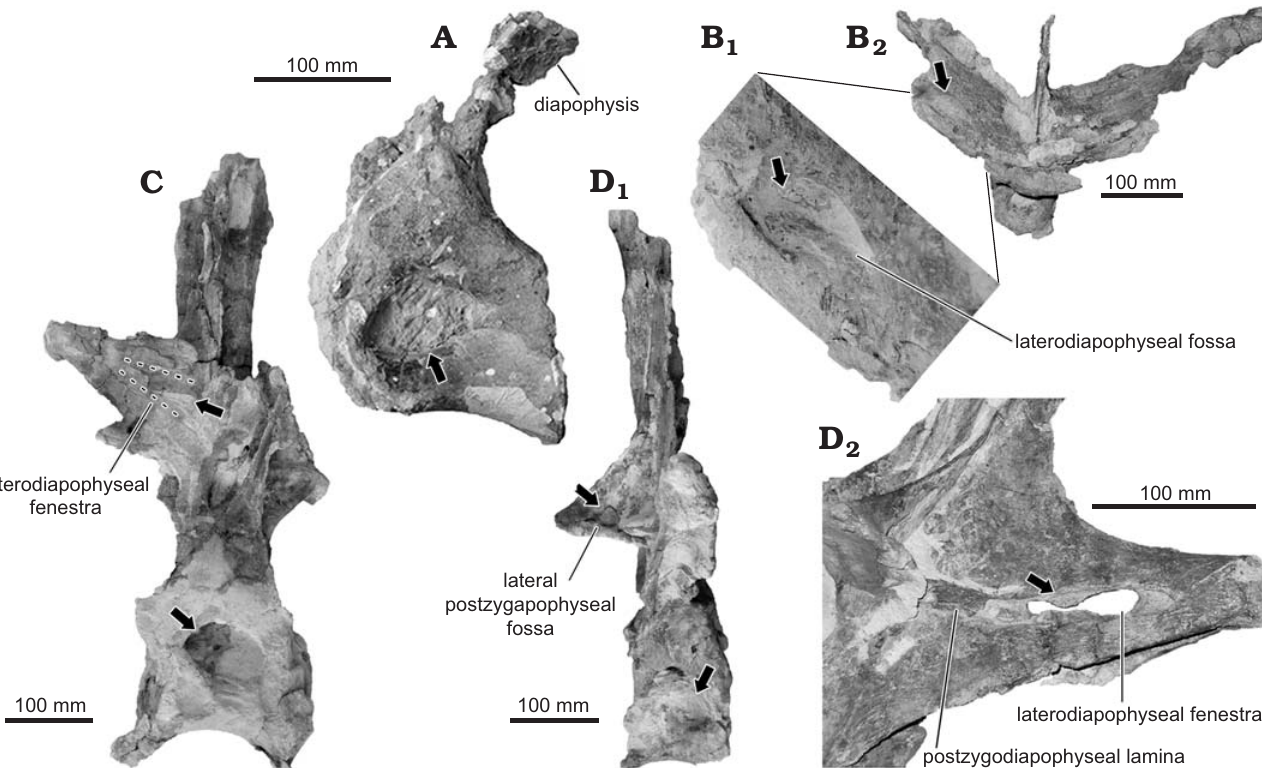
Fig. 2. Dorsal vertebrae of the rebbachisaurid sauropod Katepensaurus goicoecheai Ibiricu, Casal, Martínez, Lamanna, Luna, and Salgado, 2013a from the Cenomanian–Turonian Bajo Barreal Formation of Chubut Province, Argentina. A . UNPSJB-PV 1007/13, partial anterior dorsal vertebra in left lateral view. B . UNPSJB-PV 1007/12, partial anterior to middle dorsal vertebra in dorsal view (B 2 ), detail of right laterodiapophyseal fossa in dorsal view (B 1 ). C . UNPSJB-PV 1007/4, middle or posterior dorsal vertebra in right lateral view (dashed lines indicate approximate margins of laterodiapophyseal fenes- tra). D . UNPSJB-PV 1007/5, middle or posterior dorsal vertebra in right lateral view (D 1 ), detail of right laterodiapophyseal fenestra in right posterolateral view (D 2 ). Arrows indicate hypothesized pneumatic